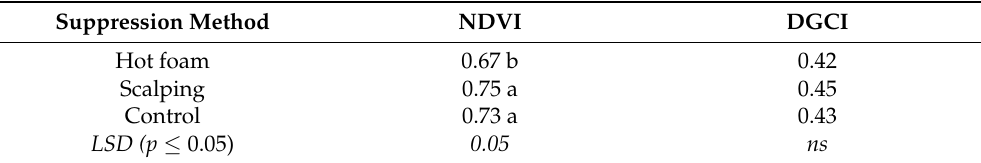
Table 8. Normalized Difference Vegetation Index (NDVI) and Dark Green Color Index (DGCI): mean effect of Lolium perenne suppression method on 1 June 2021. Suppression Method